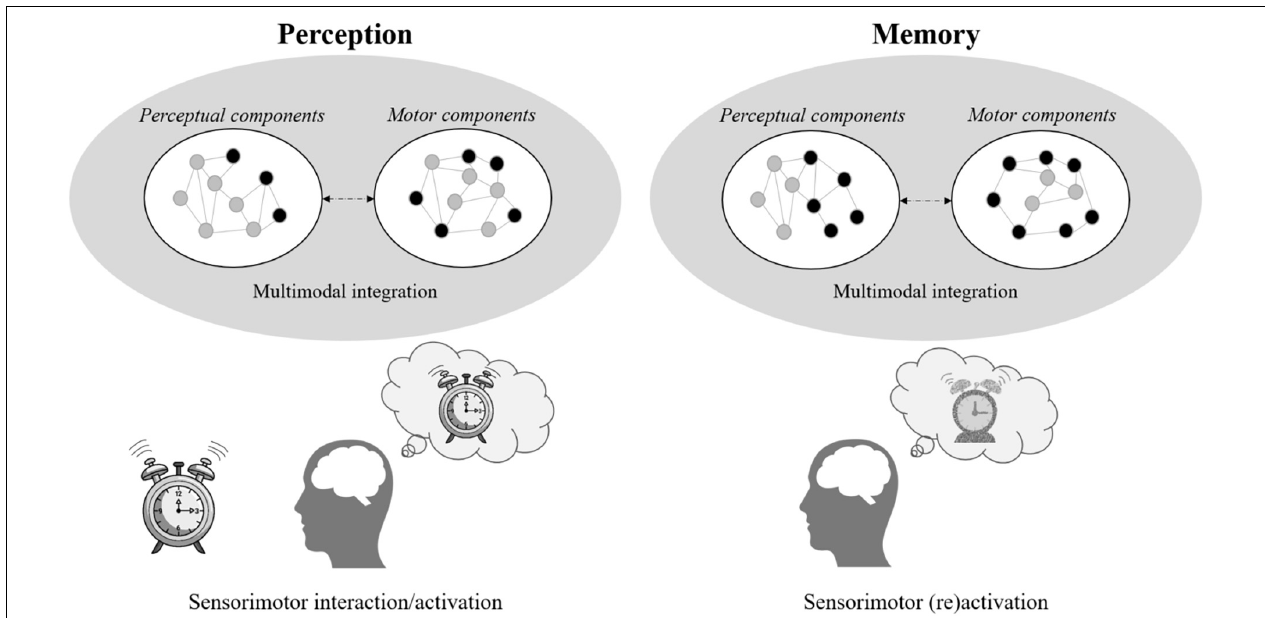
FIGURE 1 | Illustration of the sensorimotor grounded memory traces. The left panel represents the activation of the sensorimotor components when seeing an object (here, an alarm clock). The right panel represents the partial (re)activation, constrained by the present situation, of these sensorimotor components leading to the emergence of the associated memory. As memory is defined as a dynamic emergence, the representation may be slightly different from the